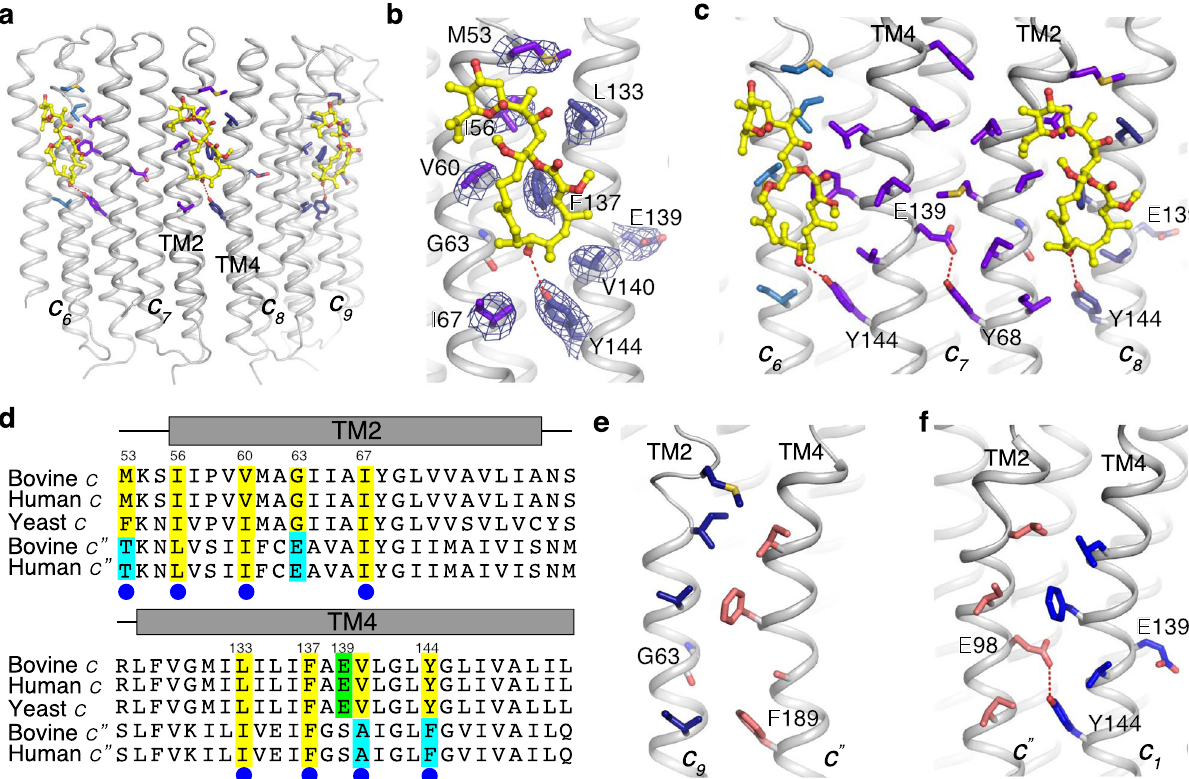
Fig. 3 Structural details of ba fi lomycin A1 binding sites. a Overall structure showing the c 6 , c 7 , c 8 , and c 9 subunits with ba fi lomycin A1. b The interaction details of ba fi lomycin A1 with the residues of the c 7 and c 8 subunits. The cryo-EM maps of the residues are shown at 5 σ level. c The residue E139 con fi nes Y68 to prevent ba fi lomycin A1 binding within one subunit c vs. binding between two adjacent subunits. d Sequence alignment between c and c ″ subunits of different species. Conserved and non-conserved residues for binding are highlighted in yellow and cyan, respectively. The catalytic residue for the proton translocation is highlighted in green. e , f Interaction details between subunit c ″ and subunit c 9 ( e ) and c 1 ( f ),